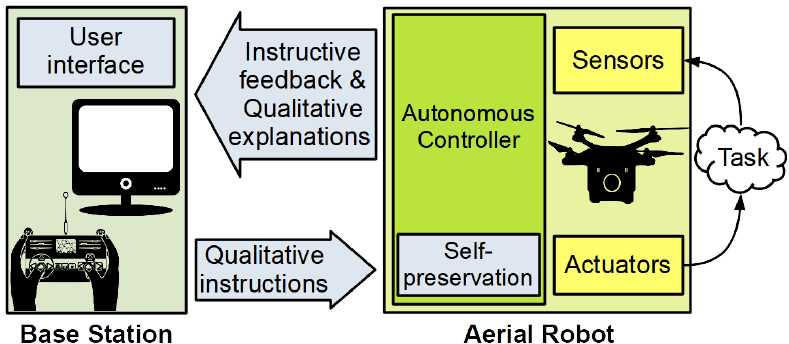
Figure 2. Overview of the visual inspection system as designed around